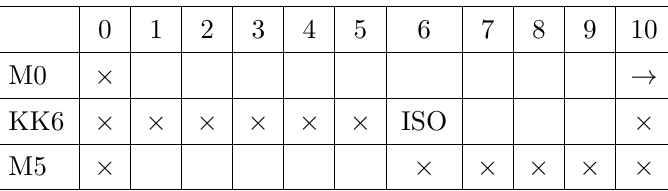
Table 4 . 1 -BPS brane intersection underlying the AdS 7 = ( Z k (cid:2) Z k 0 ) M-theory solution. The double 4 orbifold reduces the supersymmetries of the M5-brane by a